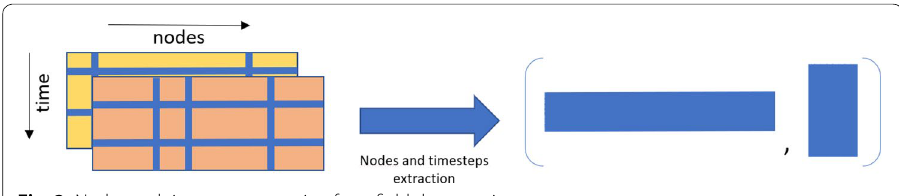
Fig. 2 Nodes and timesteps extraction from field data